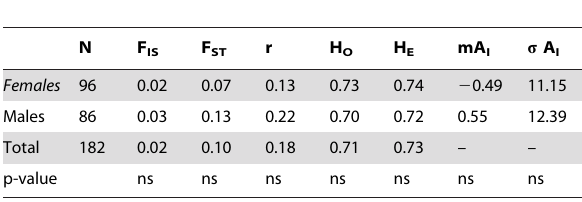
Table 3. Results for tests of sex-biased dispersal among groups in Erophylla (see Goudet et al. 2002 for more details about these